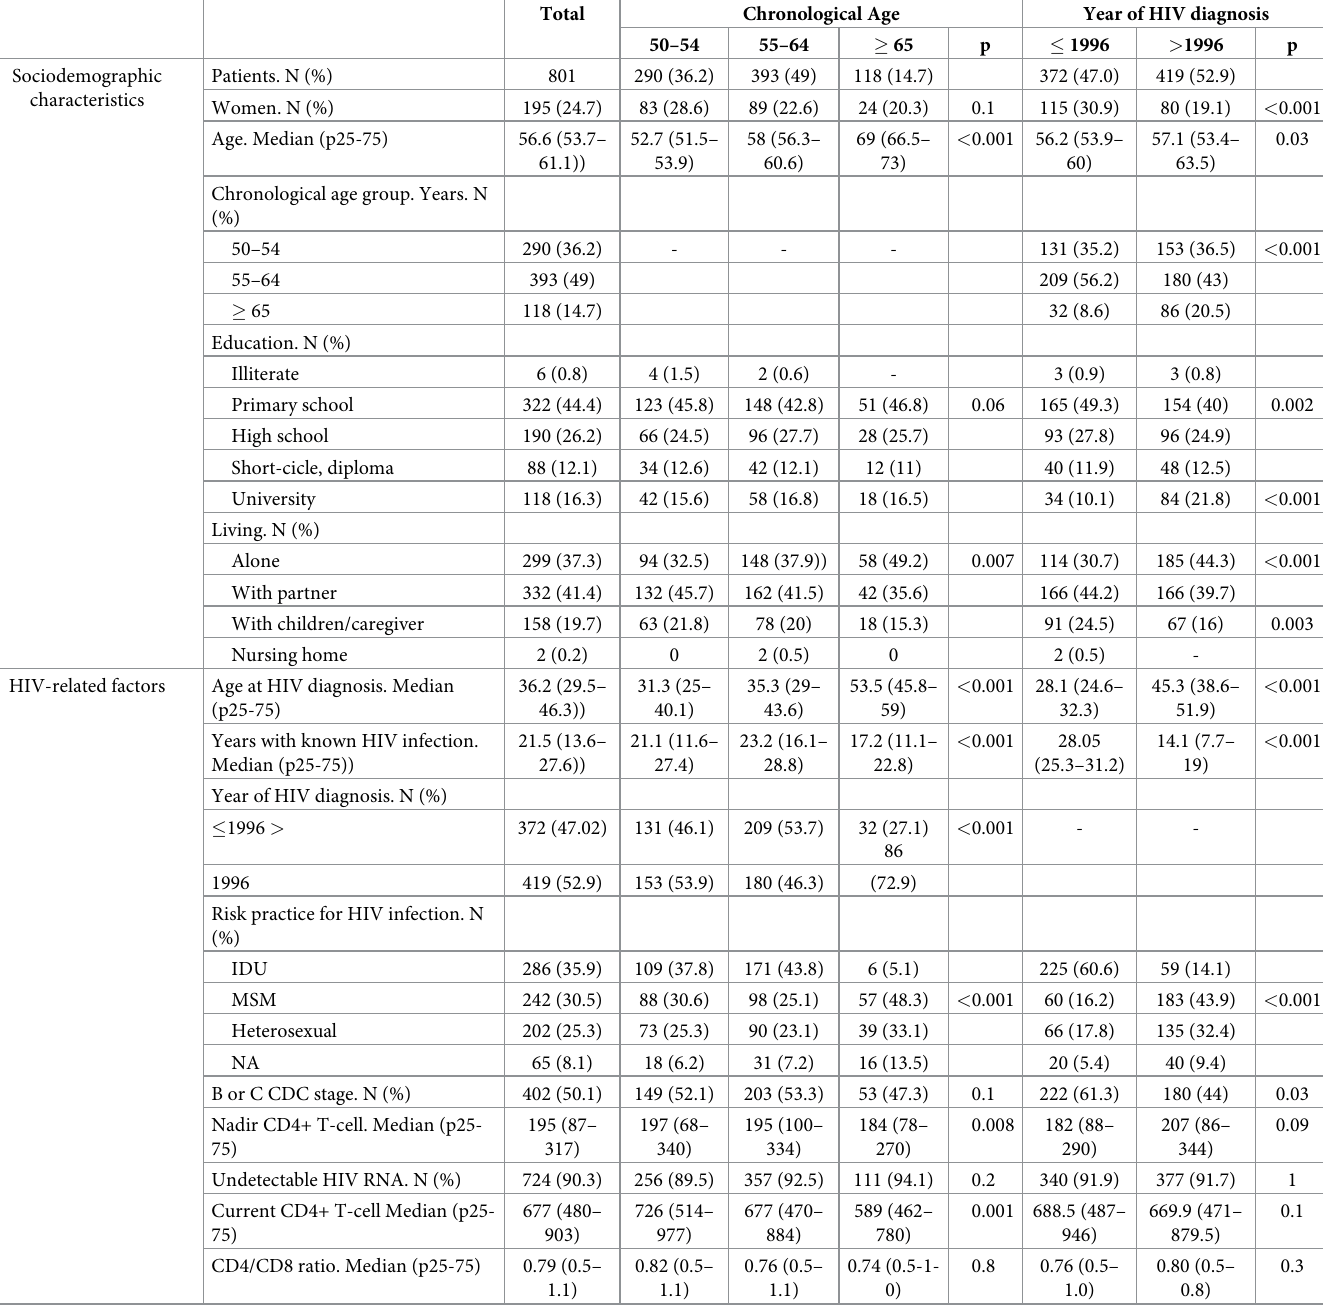
Table 1. Sociodemographic characteristics, HIV-related factors, comorbidity, and medications.